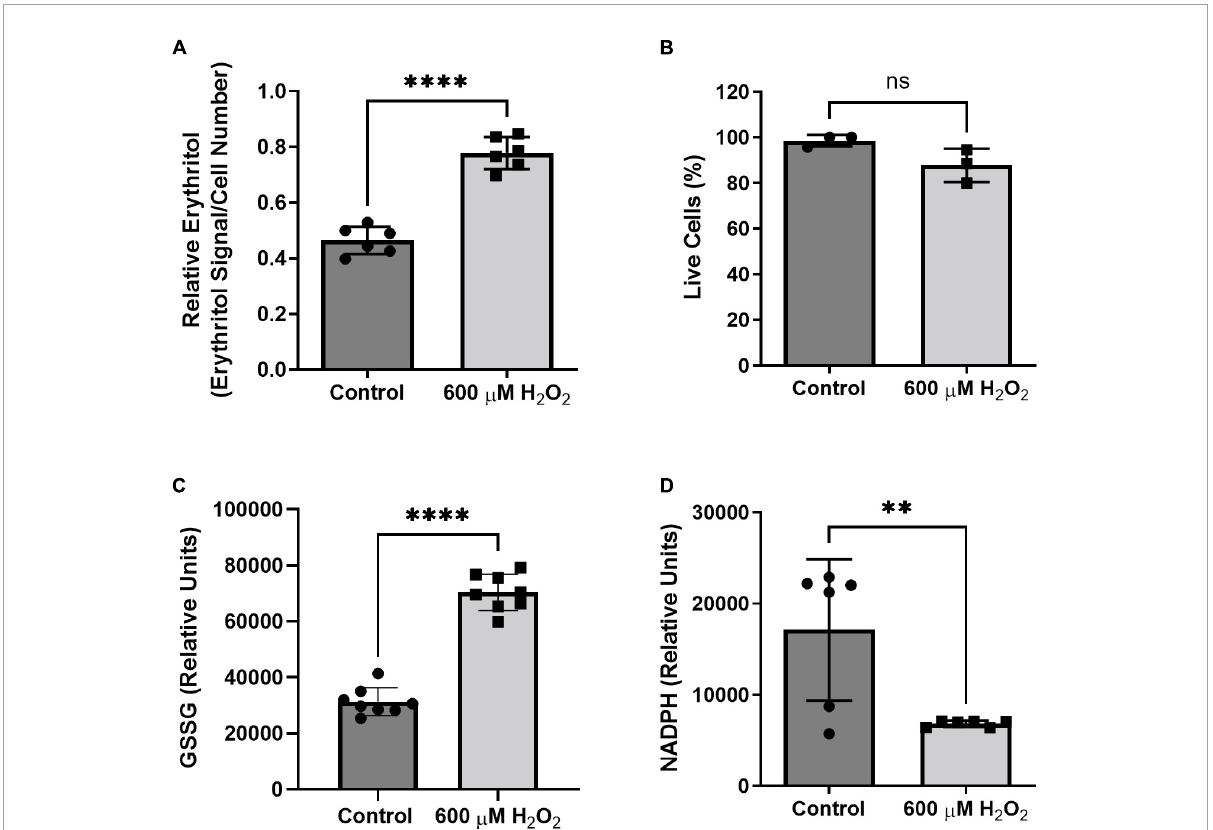
FIGURE7 Intracellular erythritol and NADPH respond to hydrogen peroxide in culture medium. Cells were exposed to 600 µ M hydrogen peroxide or vehicle for 8 h, after which (A) intracellular erythritol, (B) percentage of live cells, (C) oxidized glutathione (GSSG), and (D) NADPH were measured. Erythritol is normalized to internal standard and cell number. Data is presented as mean ± SD, n = 3–6, analyzed by unpaired t -test. ∗∗ p < 0.01, ∗∗∗∗ p < 0.0001. GSSG, oxidized glutathione; H 2 O 2 , hydrogen